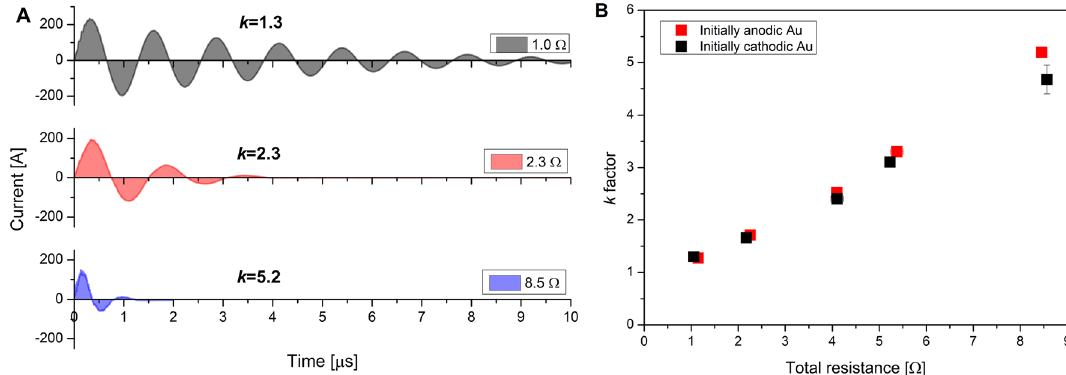
Figure 2. Illustrative current waveforms of the spark discharge measured at different total resistances ( A ). Asymmetry of the current as a function of the total resistance ( B ). See the text for the definition of the asymmetry k